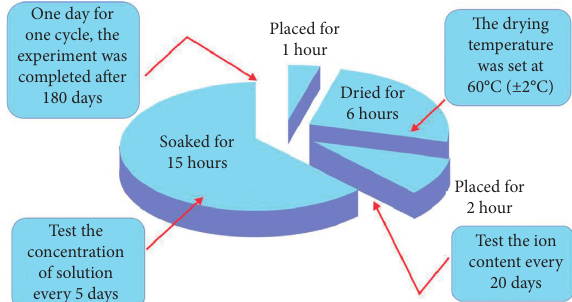
Figure 4: Drying-wetting cycle mechanism during experiment.